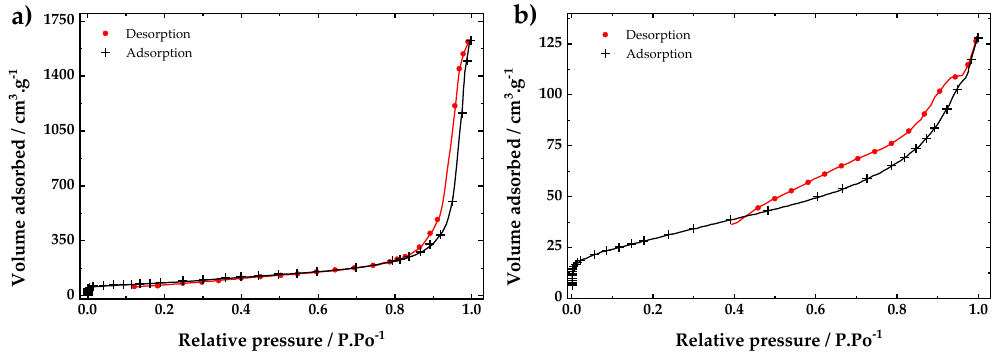
Figure 4. Adsorption-desorption isotherms of ( a ) fCNTs and ( b ) ZrO 2 -fCNTs. Table 1. Specific surface area and pore volume of fCNTs, ZrO 2 -fCNTs and ZrO 2 nanoparticles.